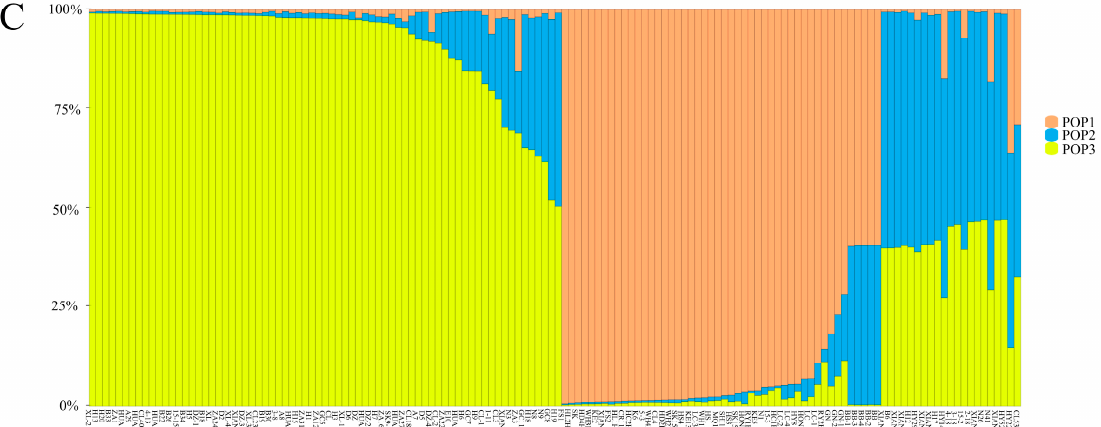
Figure 6. A structure analysis of 140 oil-tea camellia samples. ( A ): Estimated LnP(D) of K from 2 to 16. ( B ): ∆ K according to the rate of change of LnP(D) between successive K. ( C ): Genetic structure of oil-tea camellia